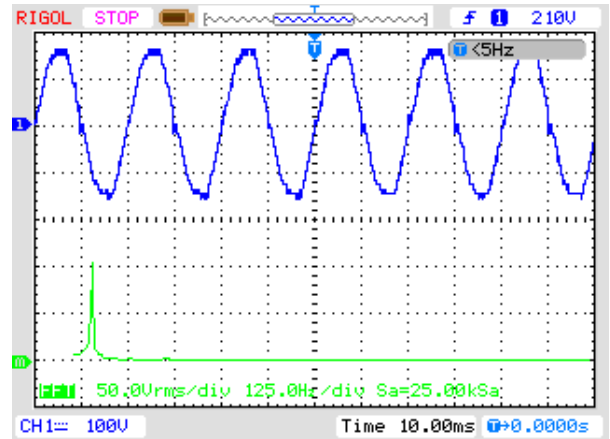
Figure 11. The practical waveform of the output voltage with PWM control and a low pass filter.